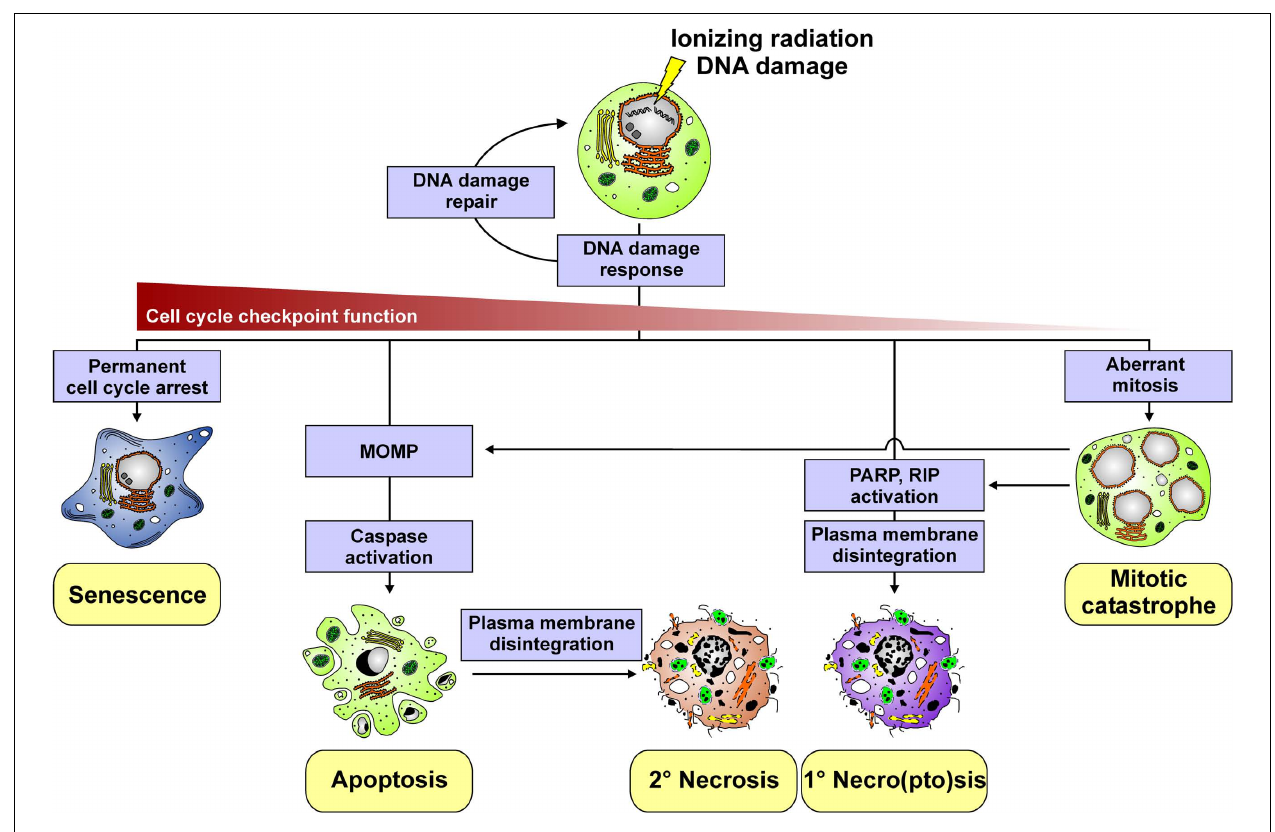
FIGURE 1 | Different cell death modalities induced by ionizing